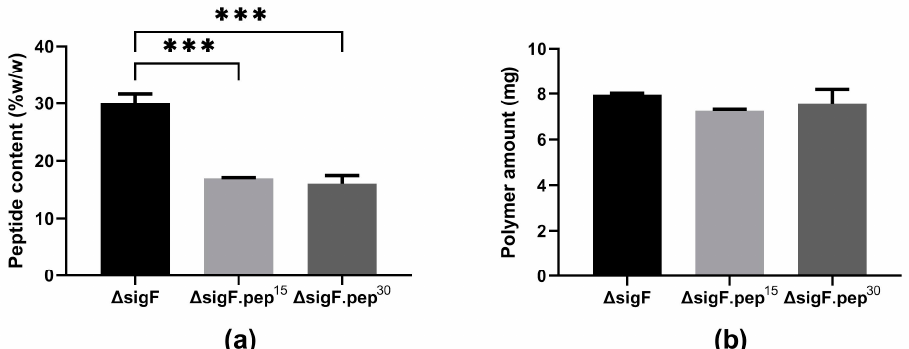
Figure 3. ( a ) Peptide content and ( b ) amount of Synechocystis ∆ sigF lyophilized polymer before ( ∆ sigF ) and after trichloroacetic acid (TCA) treatment for 15 ( ∆ sigF .pep15) or 30 min ( ∆ sigF .pep30). Peptide content was quantified by the Lowry method. Results are represented as mean ± STD of three technical replicates (*** p ≤ 0.001).